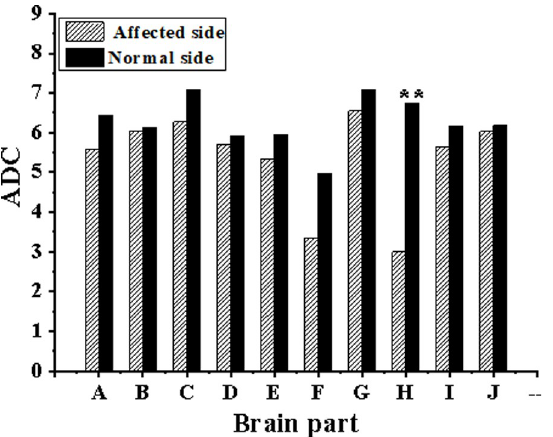
Fig 8. Comparison on ADC values different brain parts in the affected and normal side. A–J referred to the semi- oval center, the posterior horn of the lateral ventricle, the forelimb of the internal capsule, knee of internal capsule, the hind limbs of internal capsule, lenticular nucleus, the brain stem, the infarct central area, the marginal area of infarct focus, and the normal area around the focus, respectively. ( �� indicated the difference was huge in contrast to the affected side ( P < 0.01)).